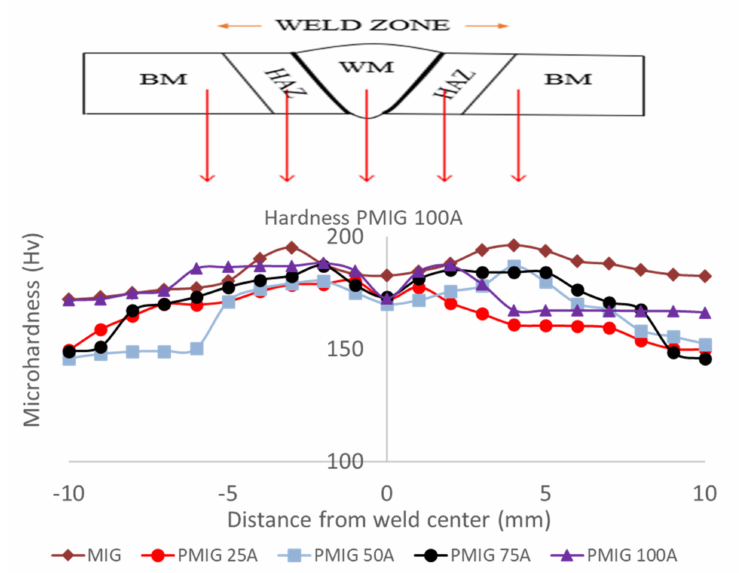
Figure 7. Graph of microhardness versus distance from the weld center for different plasma